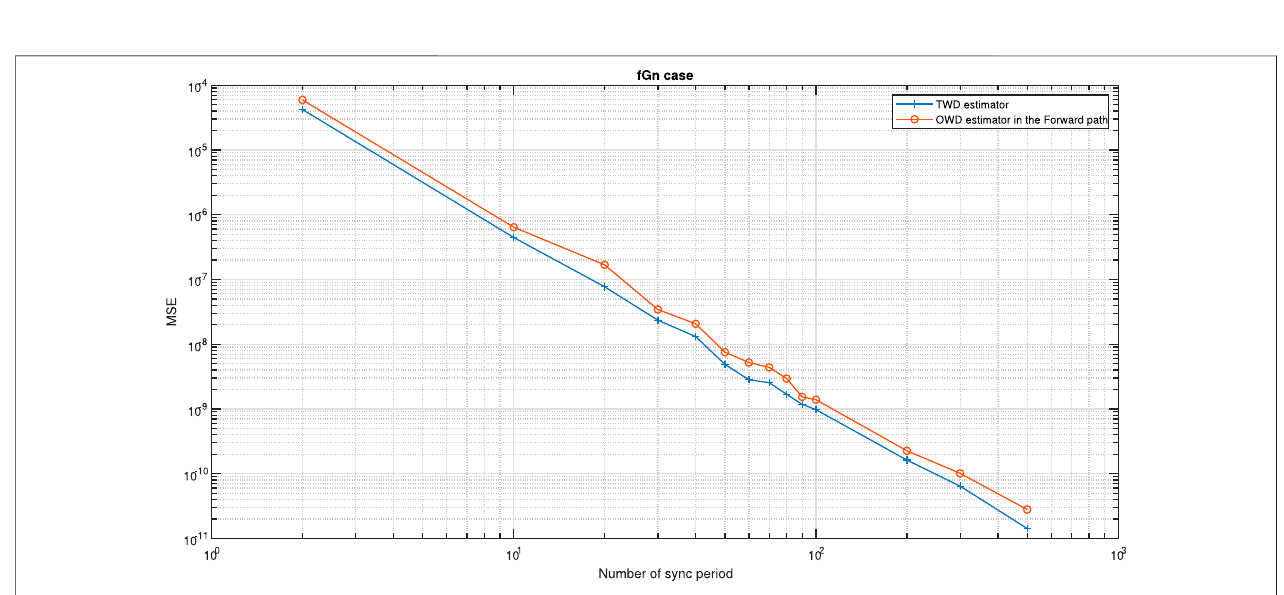
FIGURE 3 | Test case a of Theorem 8. Performance (MSE) comparison between the OWD clock skew estimator in the Forward path ( Eq. 61 ) and the TWD clock skew estimator ( Eq. 60 ). The PDV is an fGn process. α = 50 ppm , Q = 5 ms , T syn (cid:2) 15 . 6 ms ( 64 packet σ 2 (cid:2) 1 . 44 e − 8 [ sec 2 ] , Z = 1.44, ~ Z ω 2